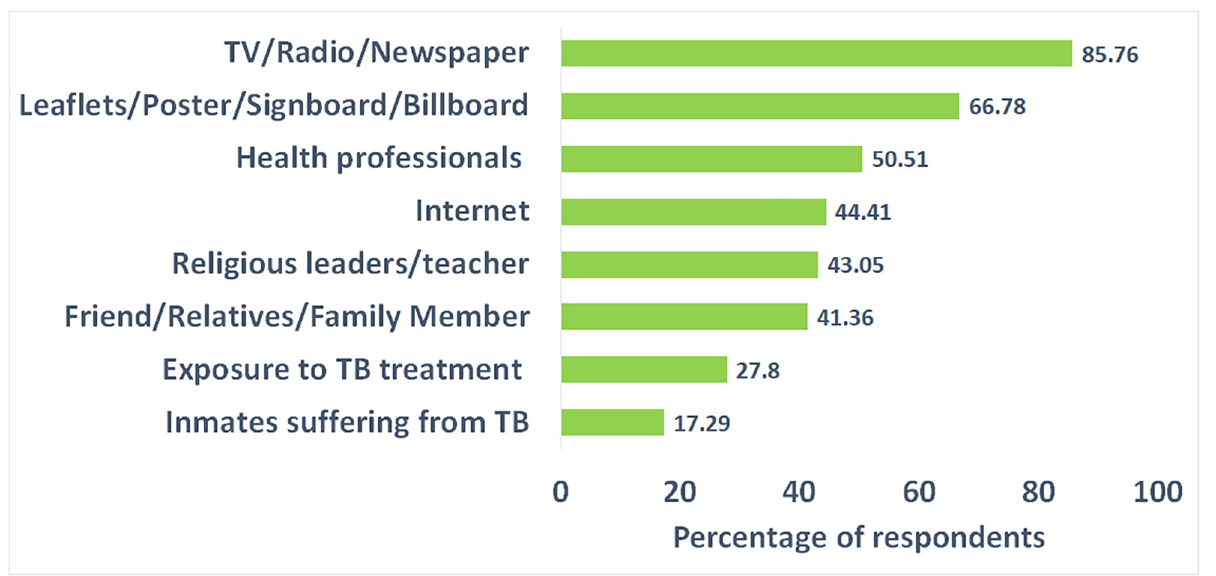
Fig 1. Source of information of the respondents about